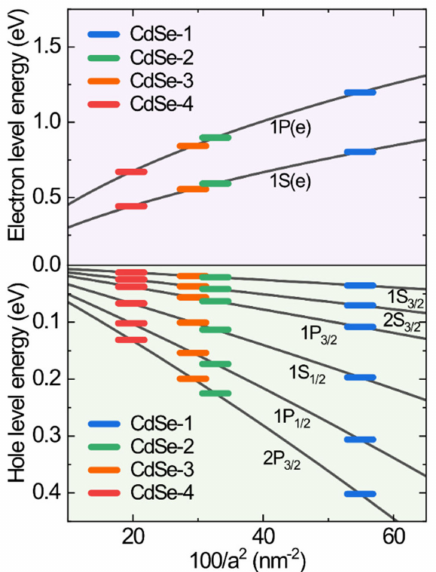
Figure 5. Size-dependent quantum size levels of CdSe QDs. Each solid line indicates a fitting curve of electron and hole levels. Color symbols show electron and hole level energies for CdSe QDs with di ff erent